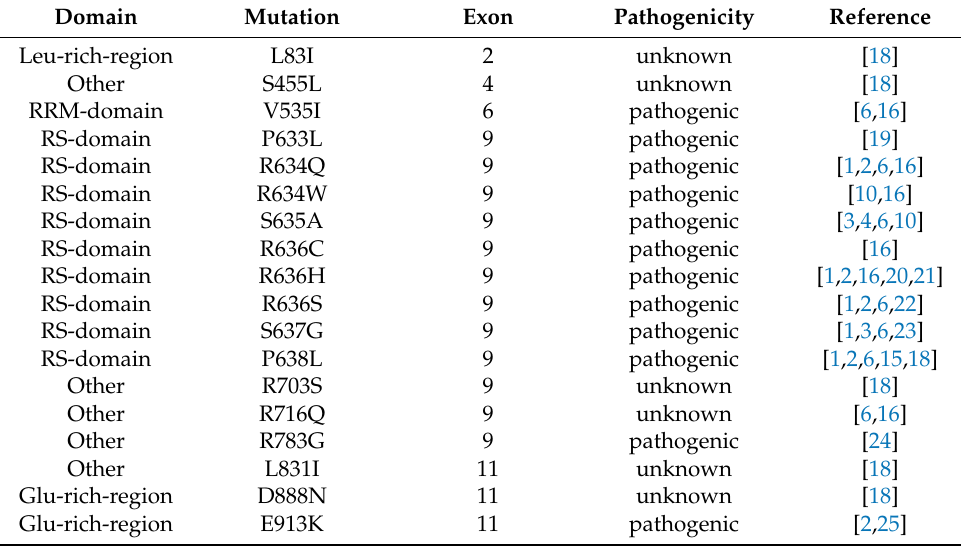
Figure 1. Modified from Parikh et al., 2019 [12]. Schematic protein structure of human RBM20 with corresponding exons. Variants shown in Table 1 are listed under the affiliated protein domains/regions. The black line chart displays the odds ratio (OR) for variant observation within the respective sections in a cardiomyopathy population vs. general population (Genome Aggregation Database [gnomAD]); underlying OR data derived from Parikh et al. [12]. Pathogenic sections predominantly concern the RS domain, the E-rich region and the RRM domain. Table 1. RBM20 variants with corresponding exons and protein domains.